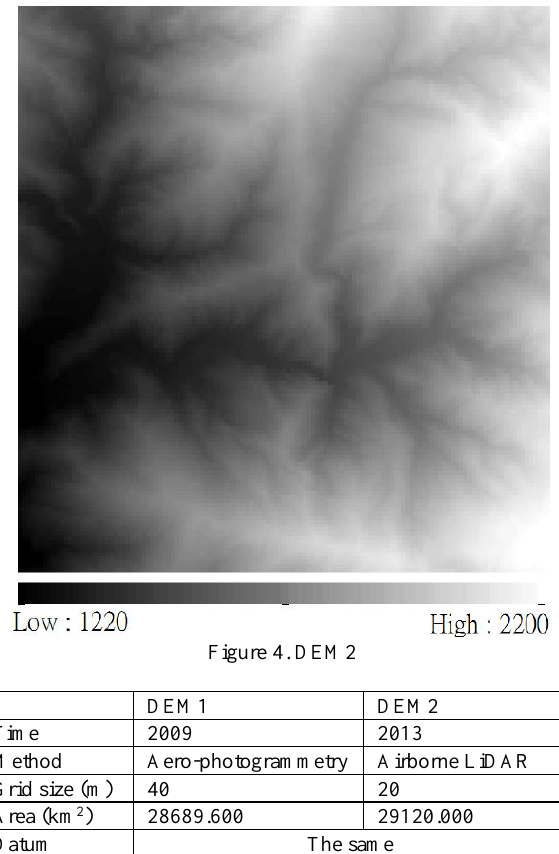
Table 1. The specification of two test